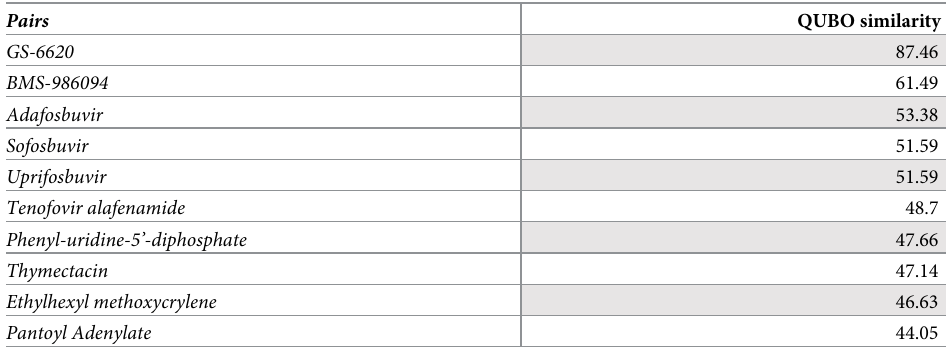
Table 5. Top 10 molecules with similarity to Remdesivir according to